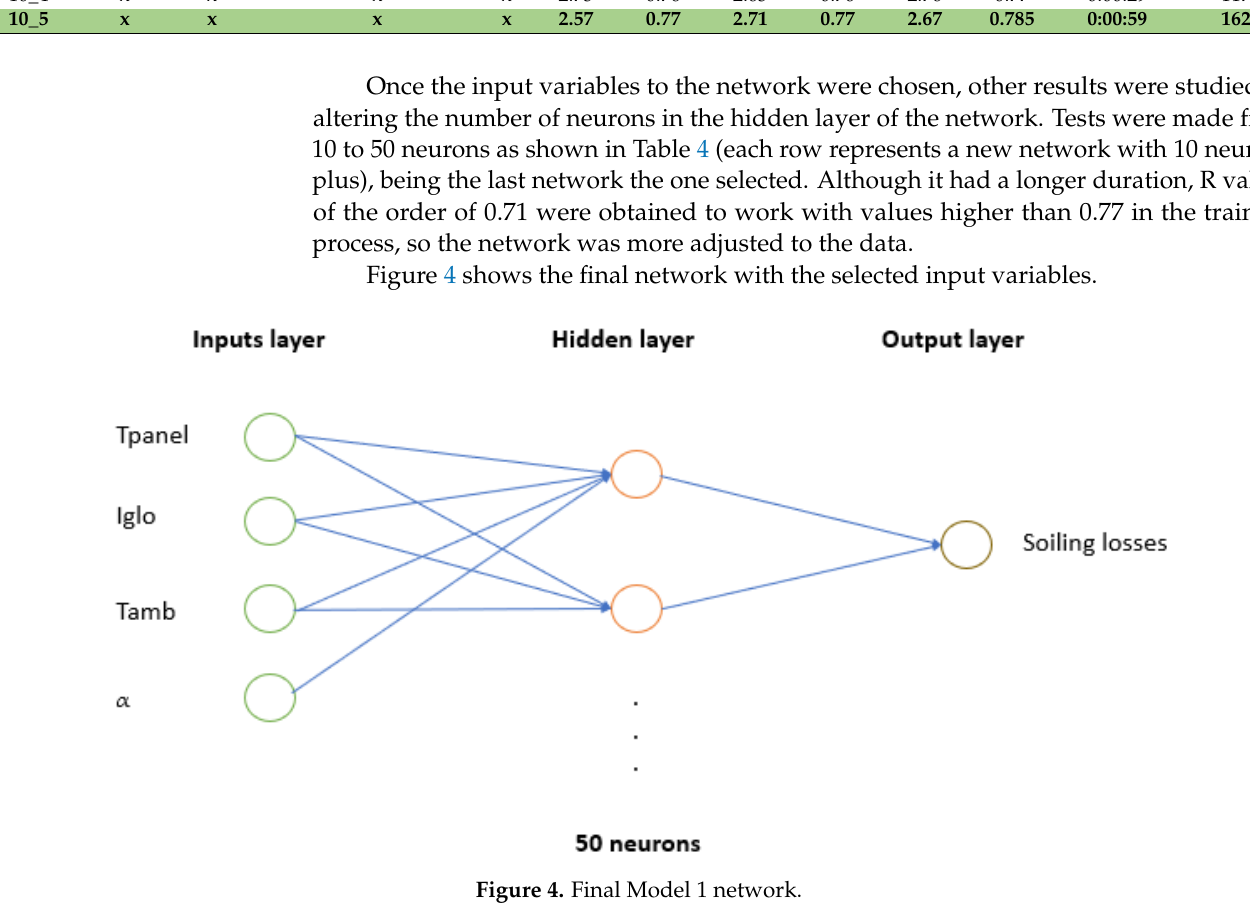
Figure 5. Initial Model 2 network. The initial Model 2 variables are the same as in Model 1, apart from adding the short- circuit current of the unmaintained panel as an extra input. Tables 5 and 6 present the different tests.